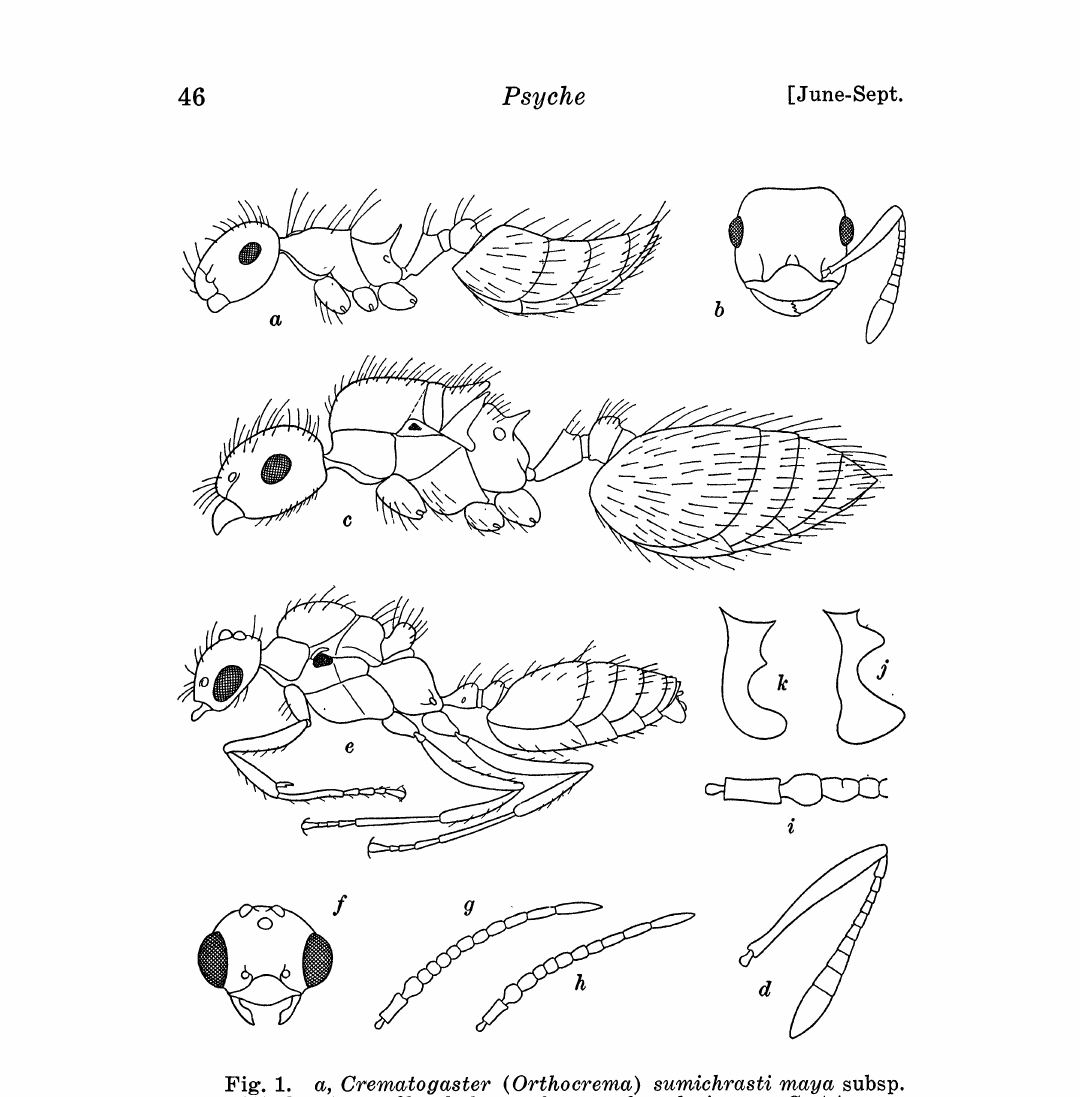
Fig. 1. a, Crematogaster (Orthocrema) sumichrasti maya subsp. nov. Worker in profile; b, head of same, dorsal view; c, C. (Apt.ero- crema) atitlanica sp. nov. female in profile; d, antenna of same; e, male in pro.file; f, head of same, dorsal view; g, 12-jointed left and h, 11-jointed right antenna of same male specimen; i, four basal joints of another male specimen more enlarged, showing partial division of third joint; j, volsella of male atitlanica, k, volsella of male sumichrasti